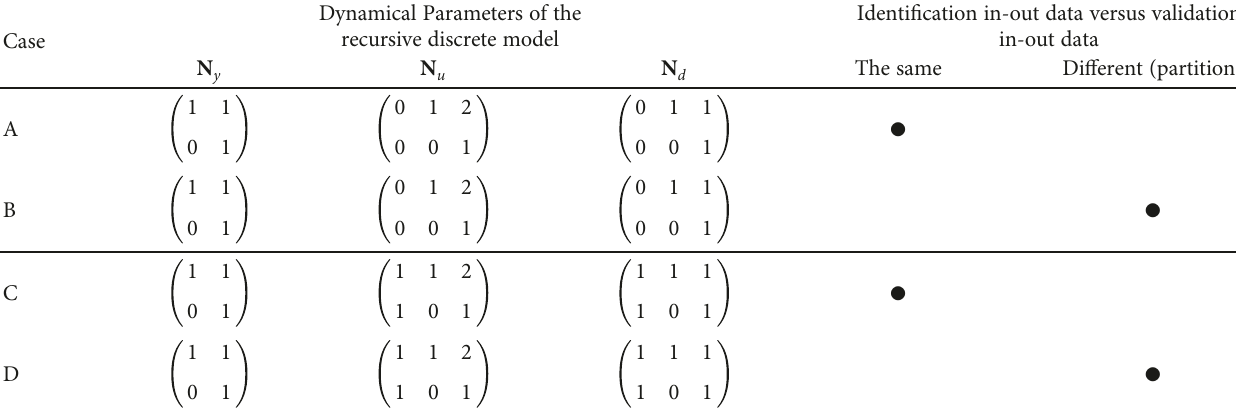
Table 9: Parameters and use of input-output data in 4 cases.